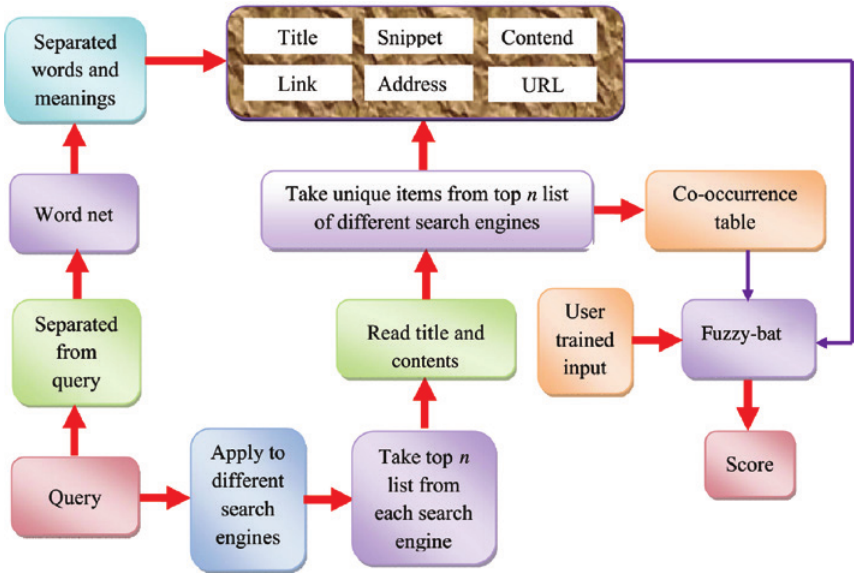
Figure 1: Proposed Optimal Fuzzy Classifier for Web Page